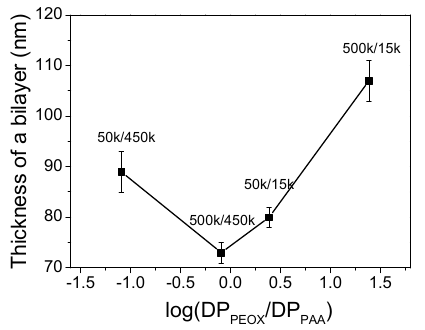
Figure 9. Thickness increment of PEOX/PAA film per assembly cycle in the linear growth region as a function of molecular weight contrast. The molecular weight contrast is expressed as log(DP PEOX /DP PAA ), where DP PEOX and DP PAA are polymerization degree of PEOX and PAA respectively. (PEOX, [EOX] = 1.0 × 10 − 2 mol/L; PAA, [AA] = 1.0 × 10 − 2 mol/L; pH 2.0; assembling time, 4 min; rinsing time, 1 min; and room temperature).